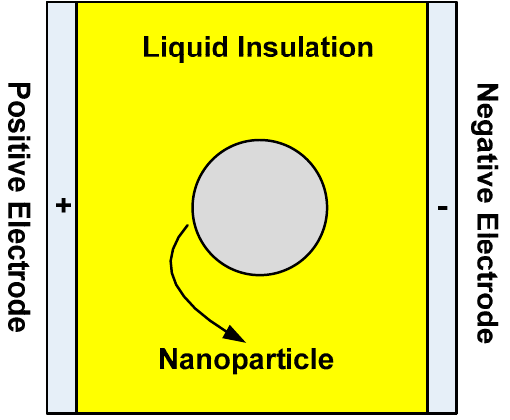
Figure 14. Simulated nanoparticle in liquid dielectric.